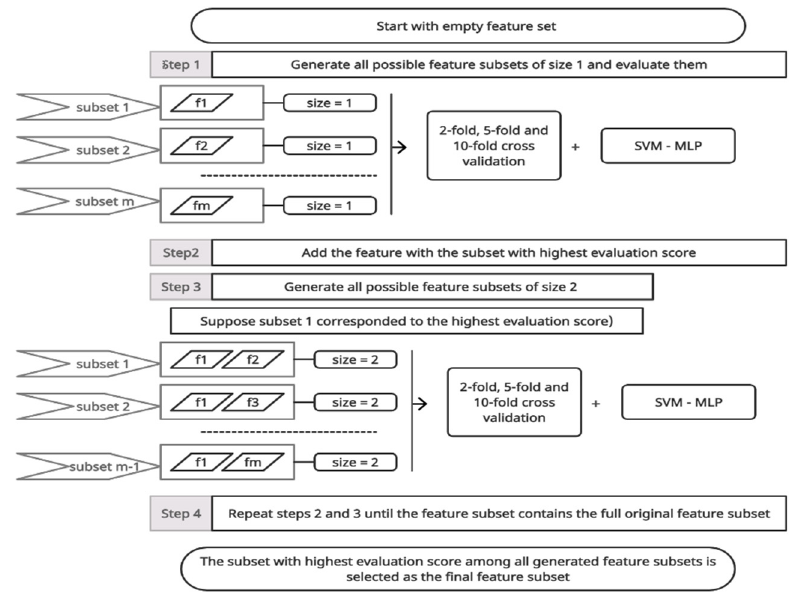
Figure 3. SFS flowchart.